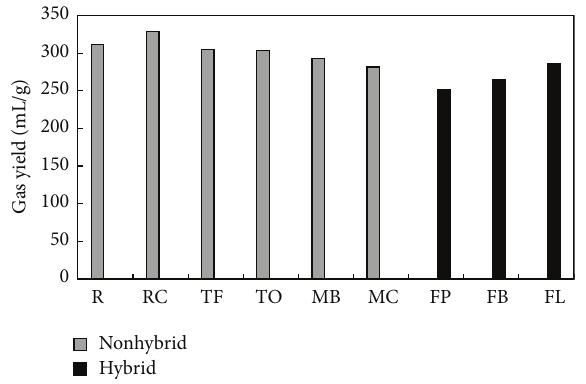
Figure 2: Total gas yield of